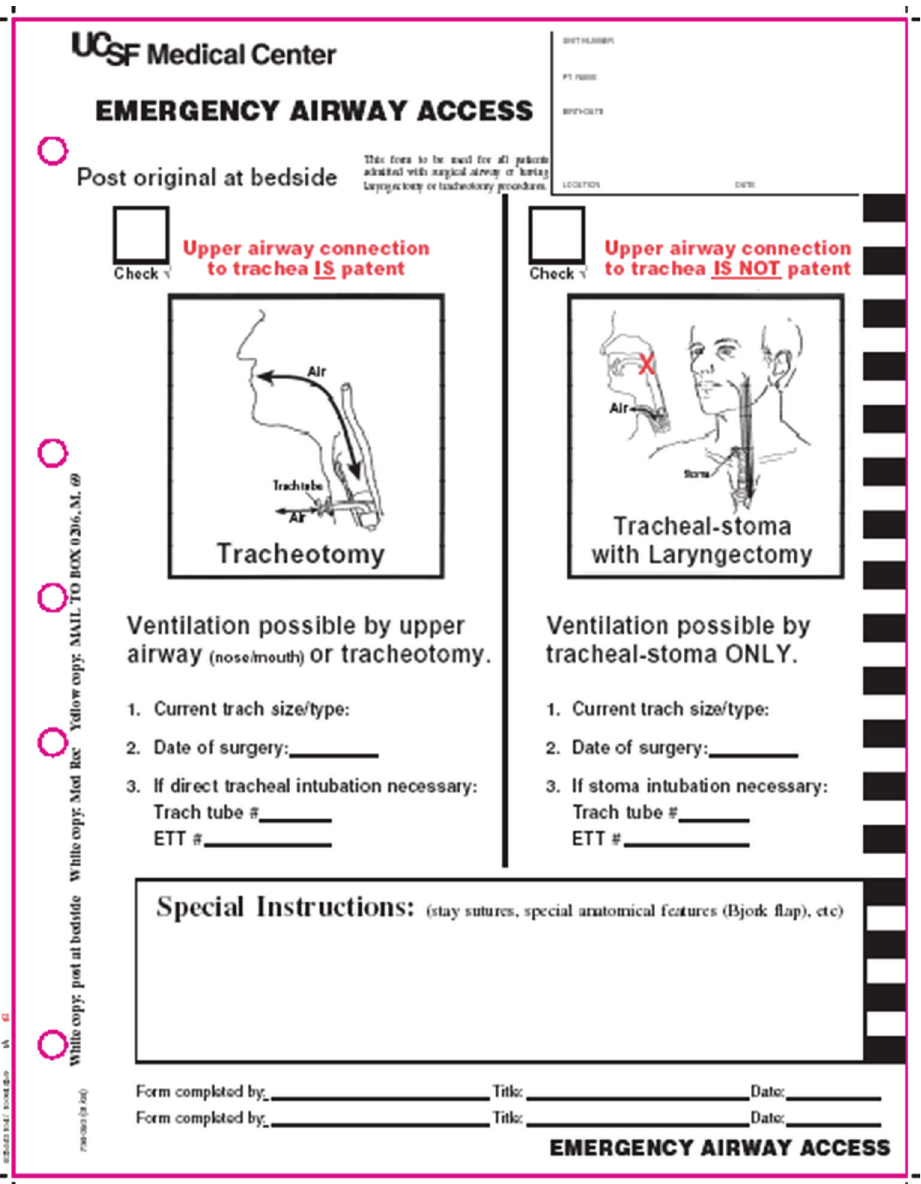
Figure 1: The UCSF Emergency Airway Access Form, posted at the bedside of all patients with surgically altered airways (reprinted with permission of UCSF and the Department of Otolaryngology-Head and Neck